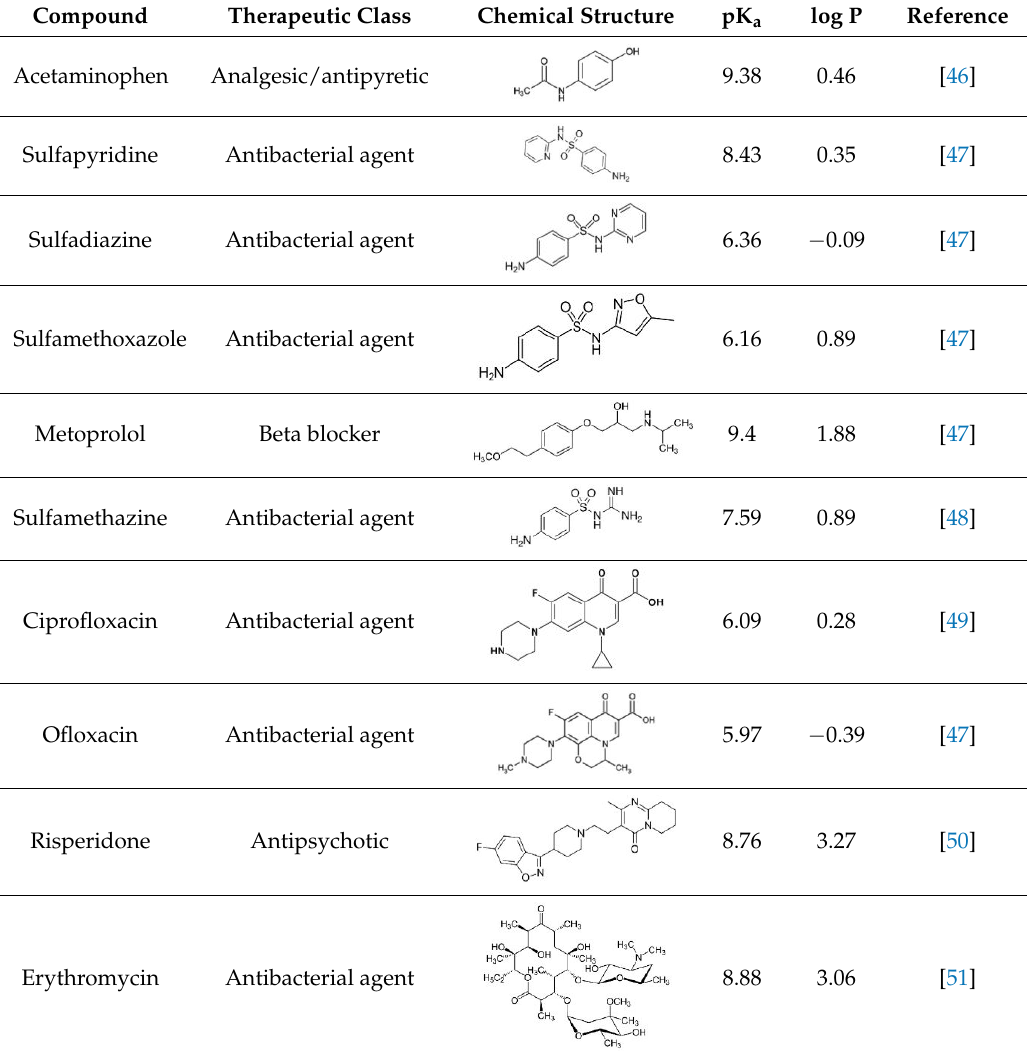
Table 1. Physicochemical properties and chemical structures of the pharmaceuticals under